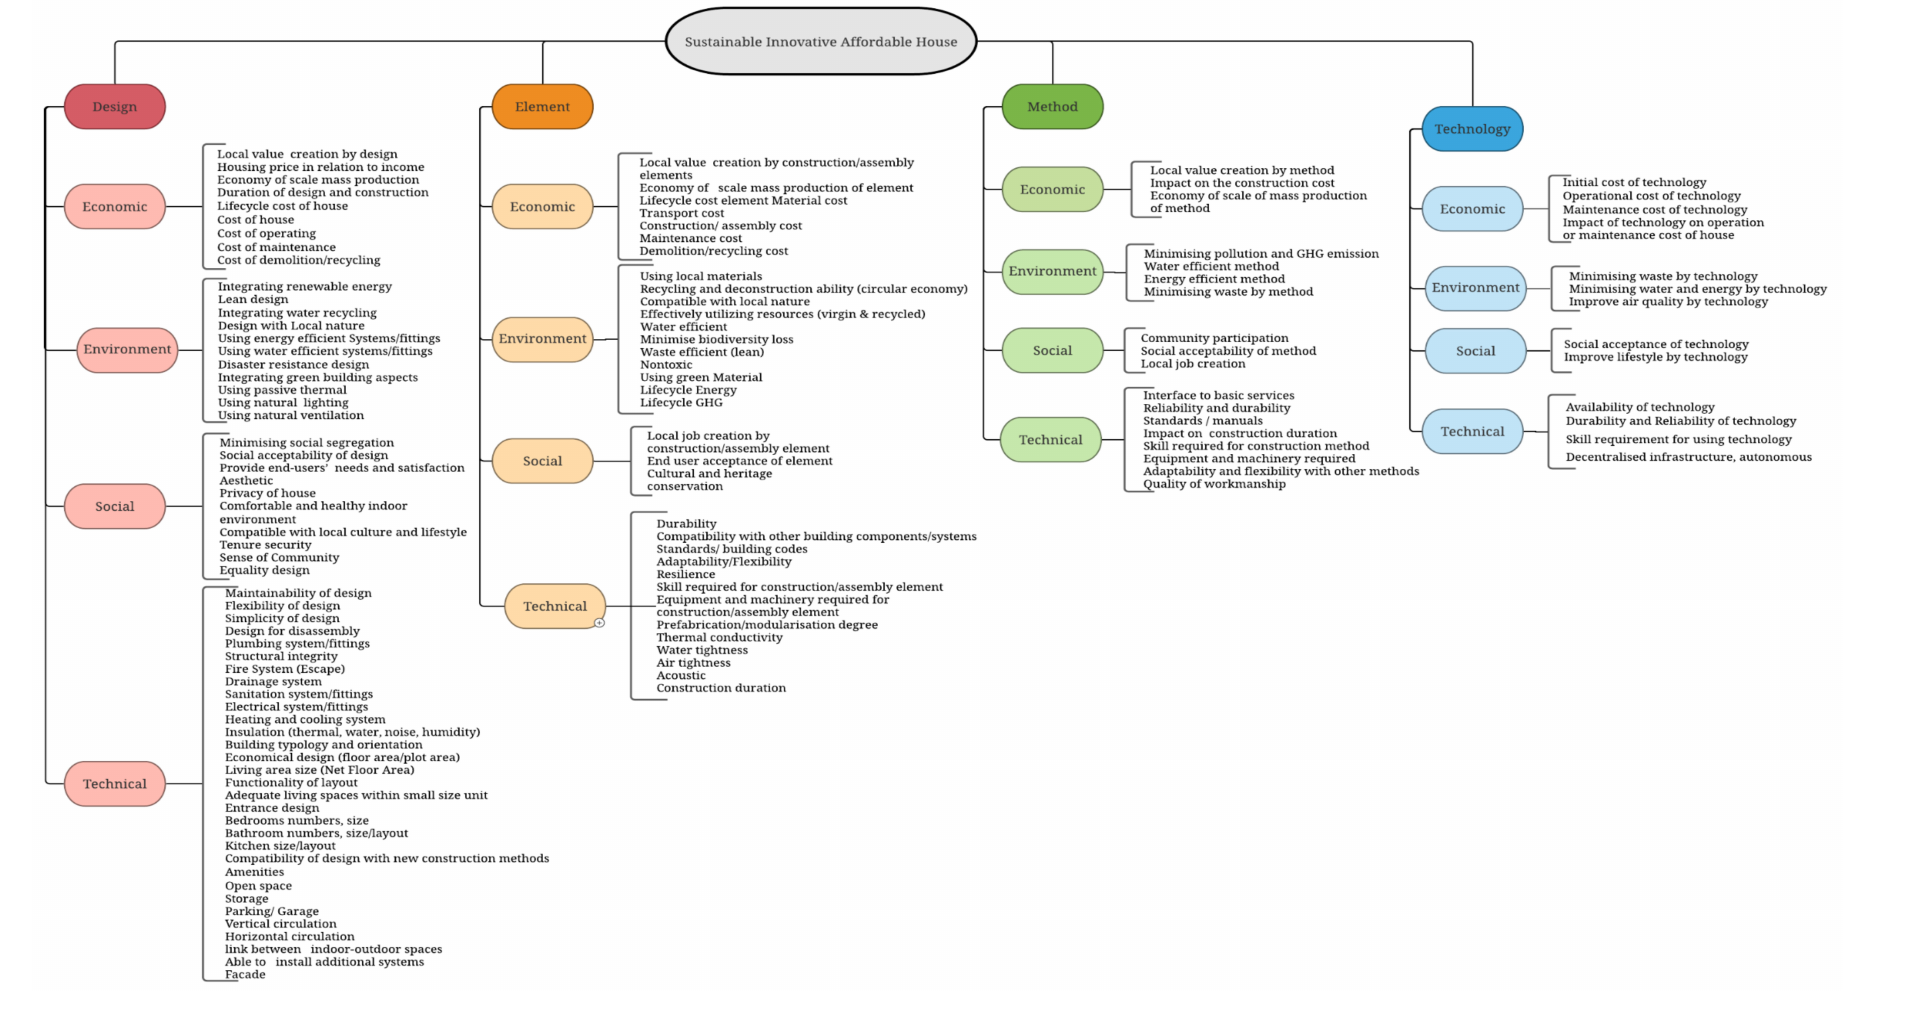
Figure 9. SIAH CSFs